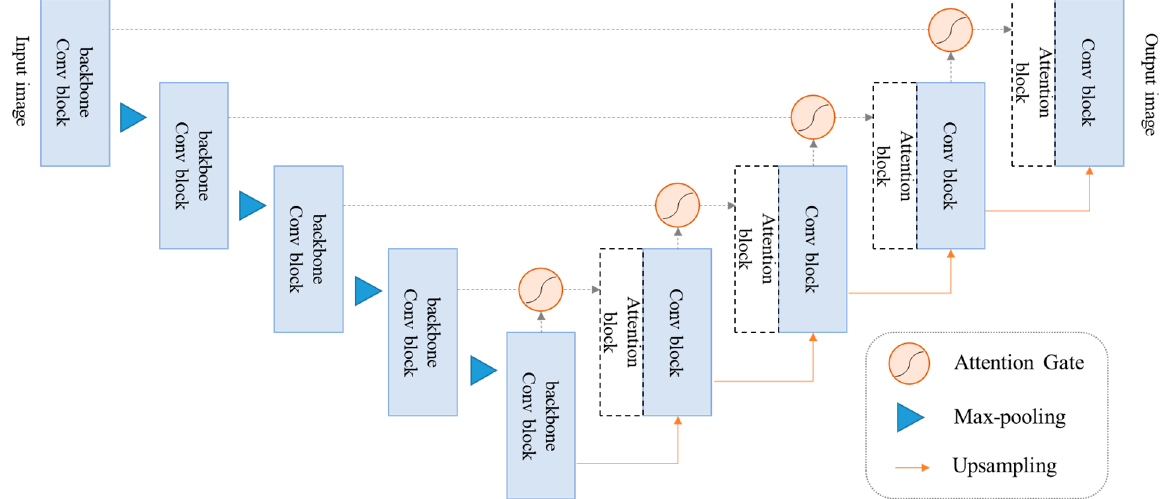
Figure 3. U-Net with the attention mechanism’s structure [34]. The encoder performs 4 downsampling. Symmetrically, its decoder upsamples 4 times to restore the features to the original image resolution. The attention gate is placed at the end of the skip connection.